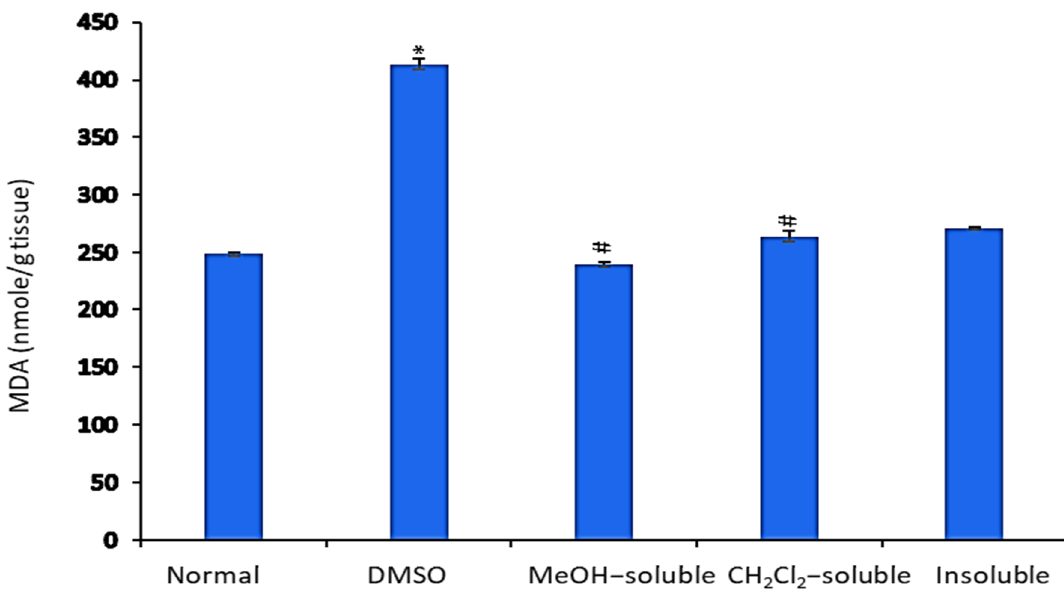
Figure 5. E ff ect of A. zerumbet extracts (MeOH, CH 2 Cl 2 , and insoluble) on malonaldehyde (MDA) activity. MDA is an indicator of lipid peroxidation. MDA levels were assessed in liver homogenate, data was represented as mean ± SEM and expressed as nmole / g tissue. Significantly (* p < 0.001) di ff erent from the normal control (untreated) and Significantly ( # p < 0.001) di ff erent from the vehicle control (tumor +